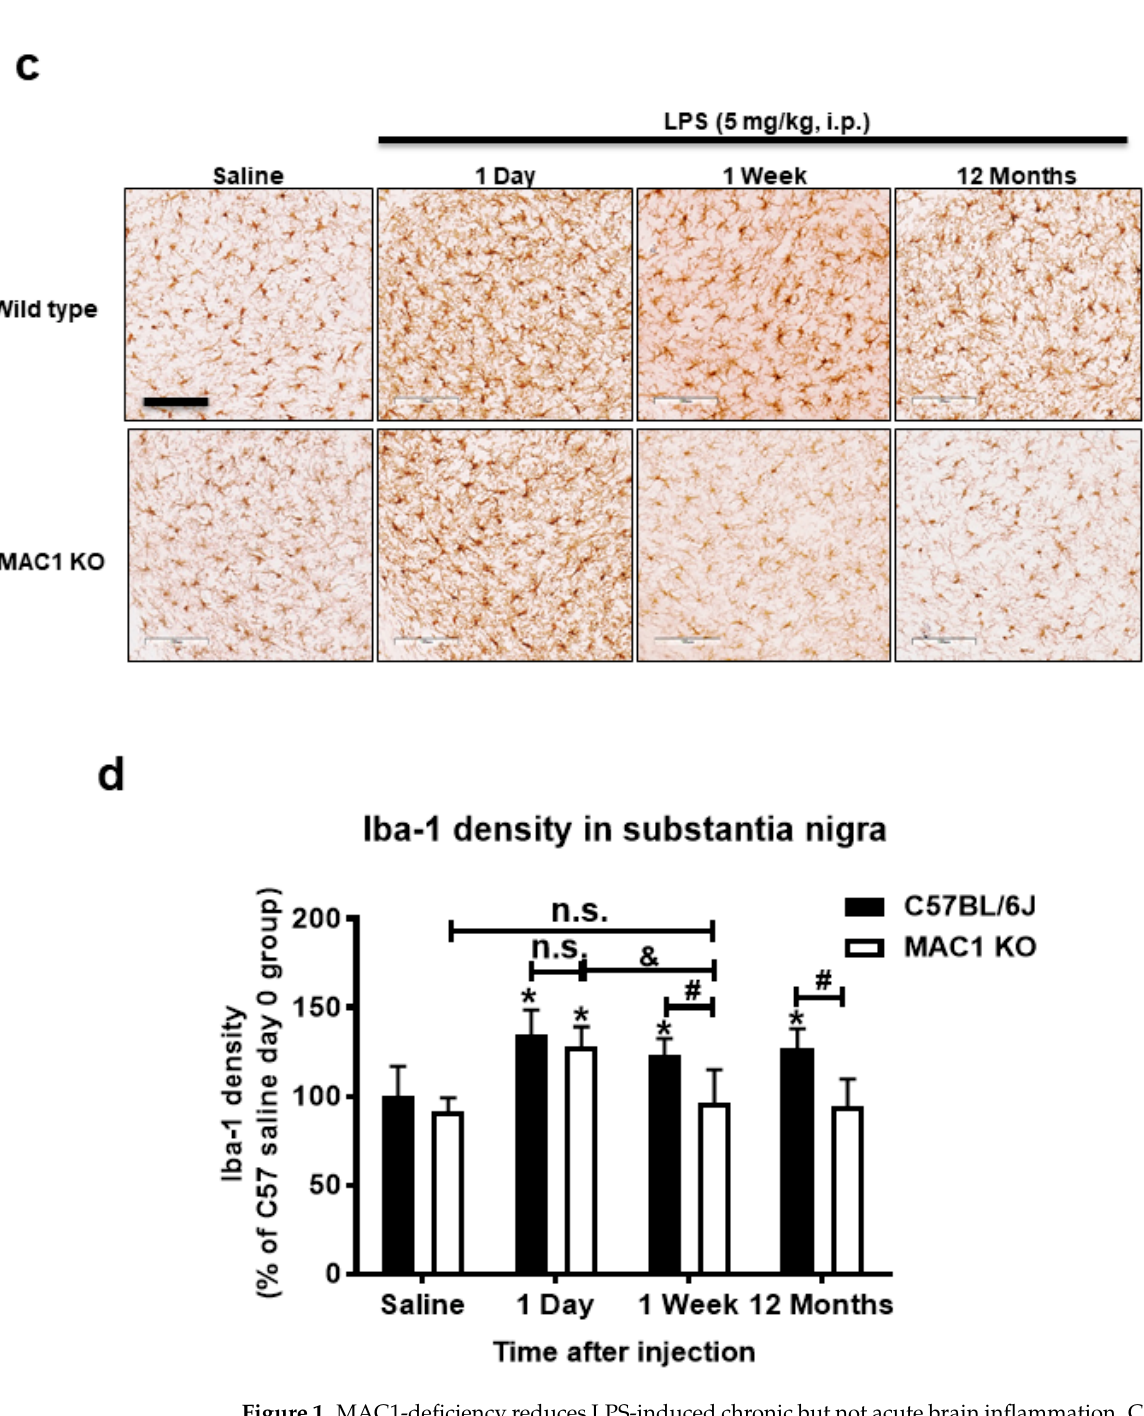
Figure 1. MAC1-deficiency reduces LPS-induced chronic but not acute brain inflammation. C57BL/6J and MAC1 KO mice were injected with saline or LPS (5 mg/kg, i.p) (N = 3 in each group and time point). The brain tissues were collected at 1 h, 7 days, and 12 months after injection for analysis of ( a ) TNF- α and ( b ) MHCII mRNA expression. ( c ) The brain slices from saline control or 1 day, 1 week, and 12 months after LPS injection were immunostained with microglia marker Iba-1, follow by ( d ) Iba-1 densitometry analysis of microglia in the substantia nigra. There are 3 brain slices stained in each group. * p < 0.05; ** p < 0.01; & p < 0.05; # p < 0.05.